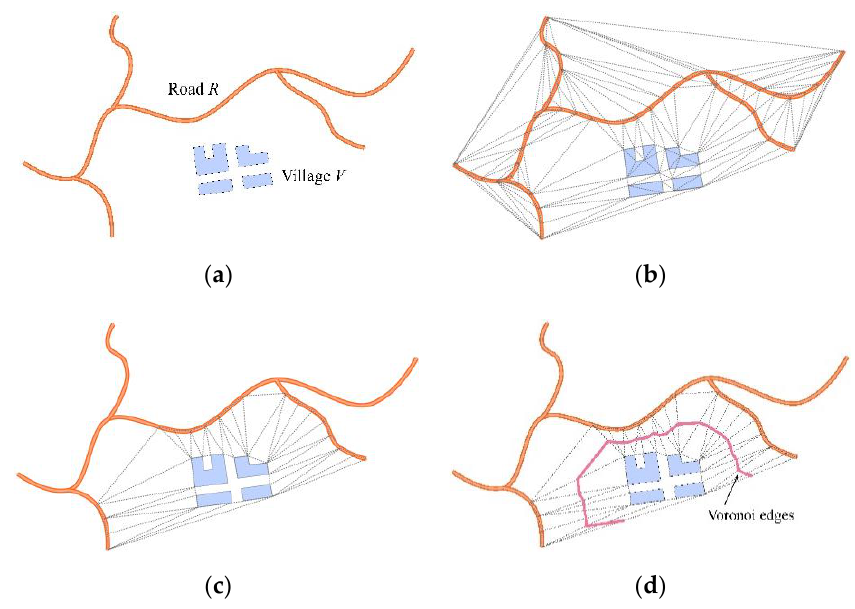
Figure 9. Procedures for computing direction relationships between two object groups: ( a ) the object groups; ( b ) triangulation of the object groups; ( c ) proximal sections of the object groups; and ( d ) direction Voronoi diagram.